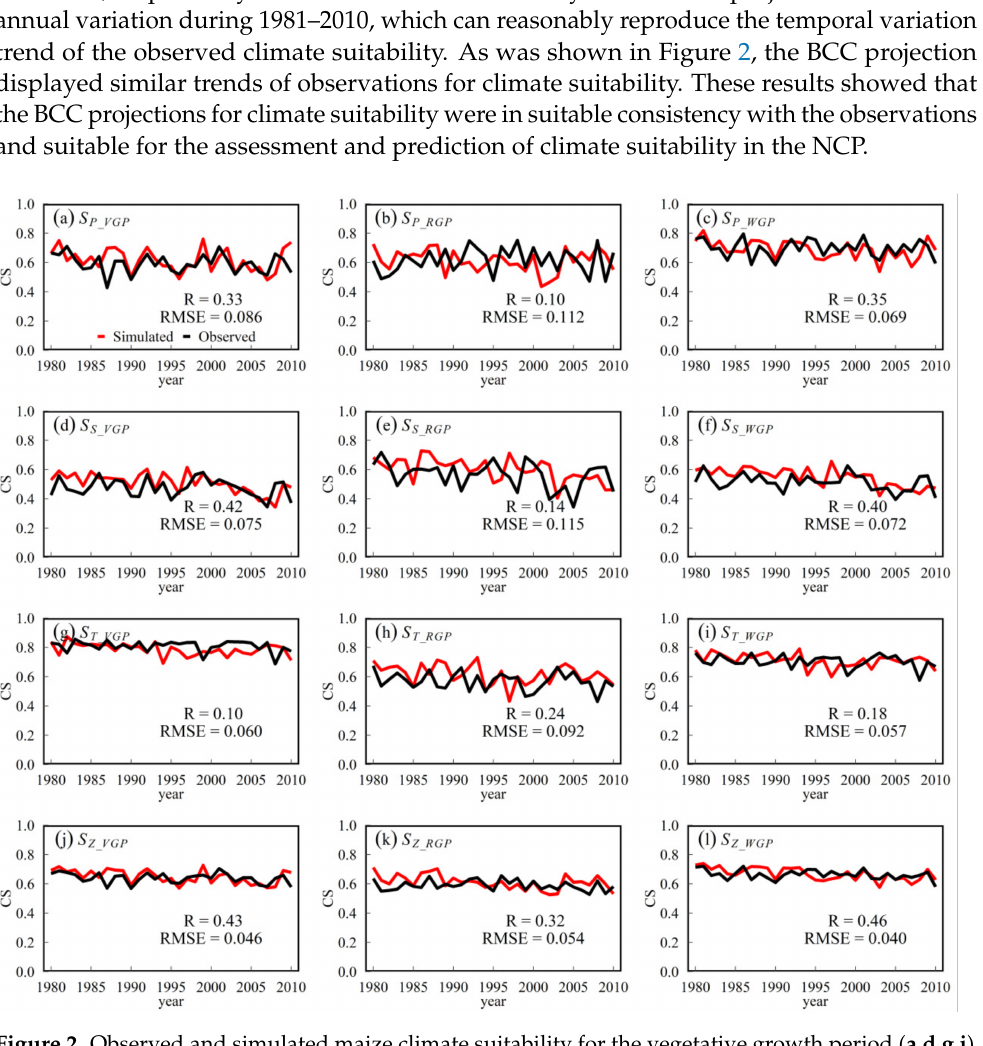
Figure 2. Observed and simulated maize climate suitability for the vegetative growth period ( a , d , g , j ), reproductive growth period ( b , e , h , k ) and whole growth period ( c , f , i , l ) during 1981–2010 across the North China